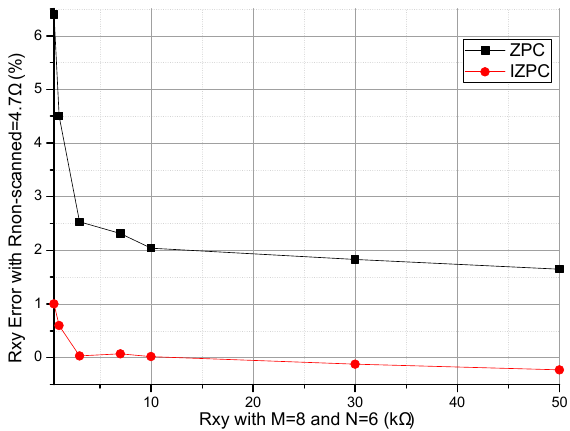
Figure 10. Result of EBT varied within 500–50 k Ω in the prototype circuit.